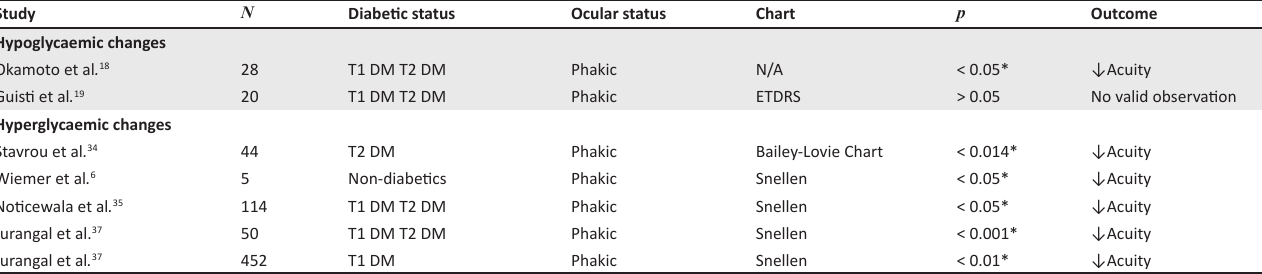
TABLE 5: Effect of glycaemic changes on visual acuity in people with diabetes mellitus. Study